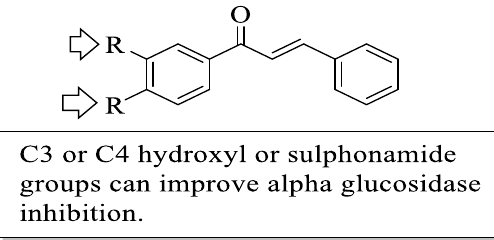
Figure 23. SARs of chalcones for α -glucosidase inhibition activity [59].